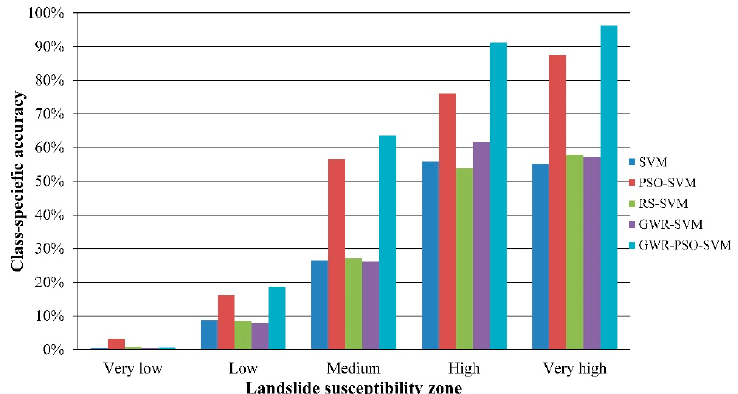
Figure 16. The class-specific accuracies by different prediction models using the fixed interval method.